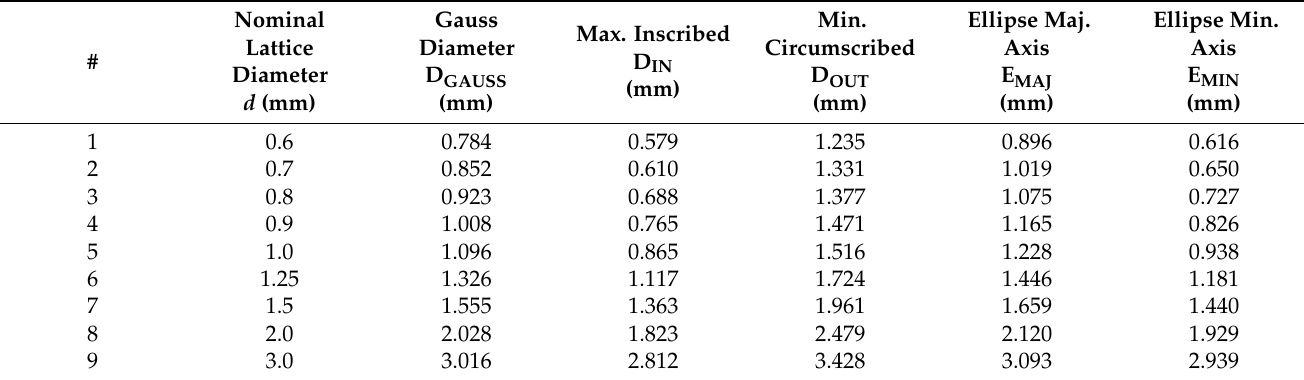
Table 5. Median values of diameters (axes lengths) for all the fitting elements of all structures.